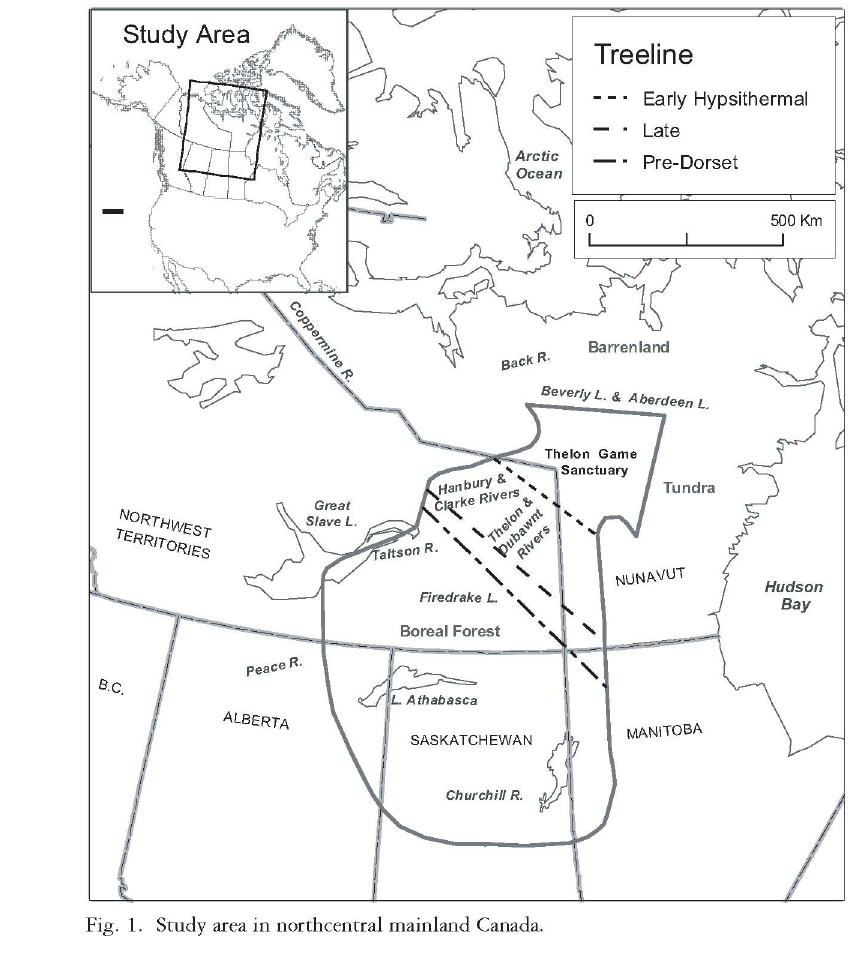
Fig. 1. Study area in northcentral mainland Canada. And yet the distinctness of artifact traits between ranges could be differentiated. This was consistent with caribou herd data recalculated by Parker (1972) from Miller & Robertson (1967). Six percent of ear- tag returns for Kaminuriak caribou came from range normally occupied by Beverly caribou. Then, using ear-tag returns during the same time period from his study, Parker found that about 5% of Beverly tagged caribou came from range normally used by Kaminuriak caribou. This suggests about 94% herd discreteness between the Beverly and Kaminuriak herds, adding additional support to the belief that the caribou in each population are normally faithful to their respective traditional annual range and offers support for an explanation of why, despite overall similarity, I could separate Beverly and Kamin uriak traits for Pre-Dorset tools. Slight differences between each range probably resulted from limited human contact because hunters focused on the cen¬ ter of the ranges where migrating herds were